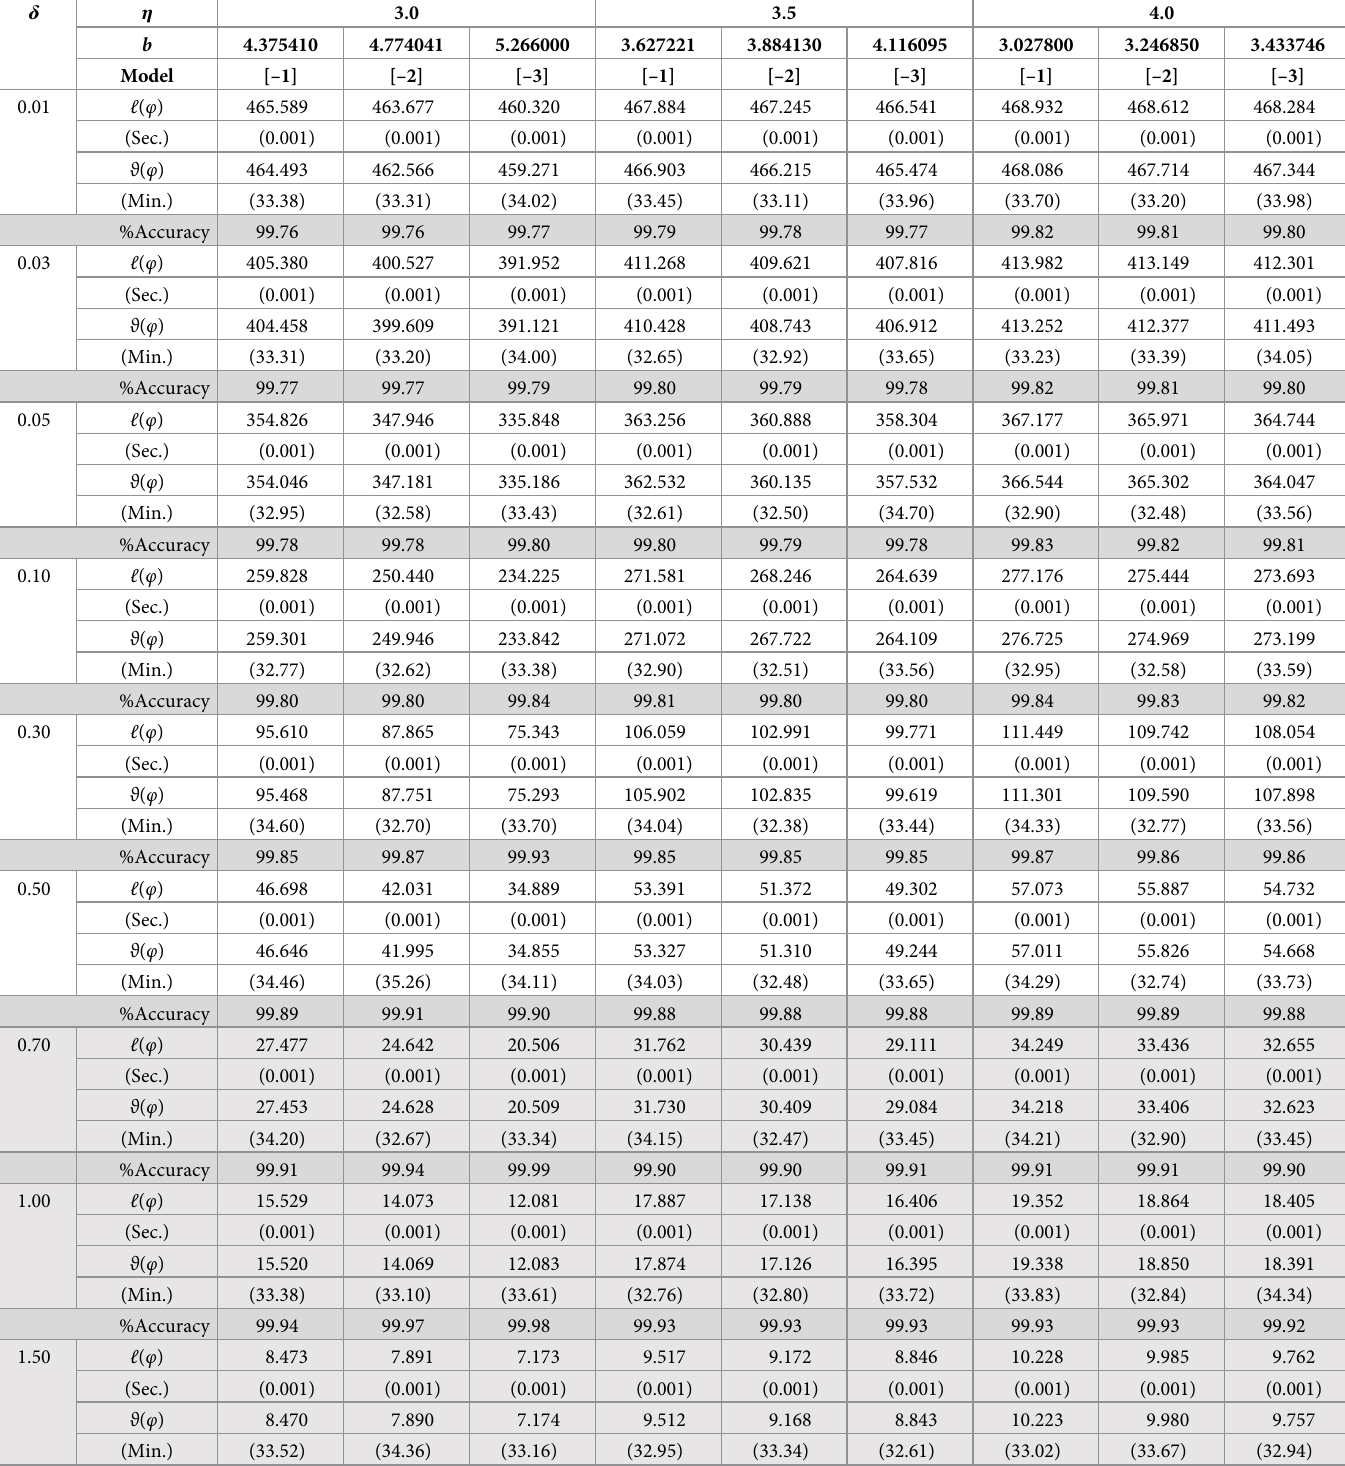
Table 5. Comparison of the ARL 1 values obtained using the analytical and numerical ARL methods for long-memory SARFIMAX( P , D , Q , r ) s processes with expo- nential white noise on a CUSUM control chart for ARL 0 = 500 with F 1 = − 0.1, F 2 = 0.2, Θ 1 = 0.1, and ω 1 =